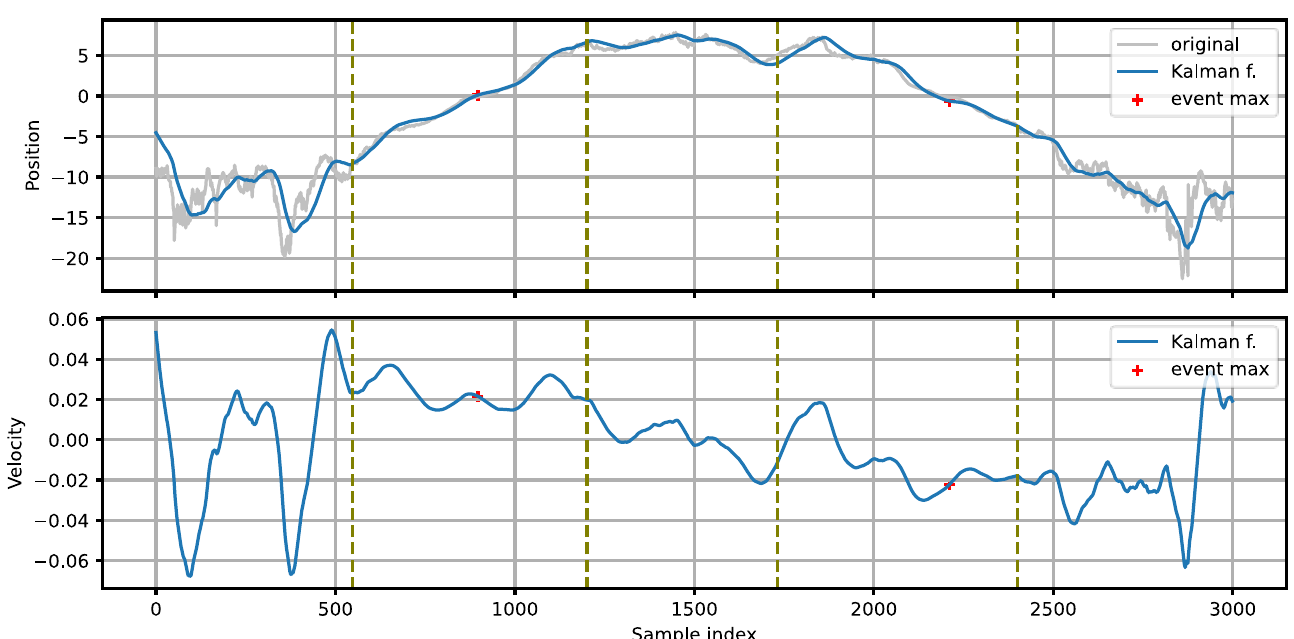
Figure 5. Position and velocity of the sound source, estimated with the Kalman filter. The light line in the position plot shows the input to the Kalman filter. The vertical dashed lines mark the edges of the detected events. The positions of the event maxima are marked with plus signs.